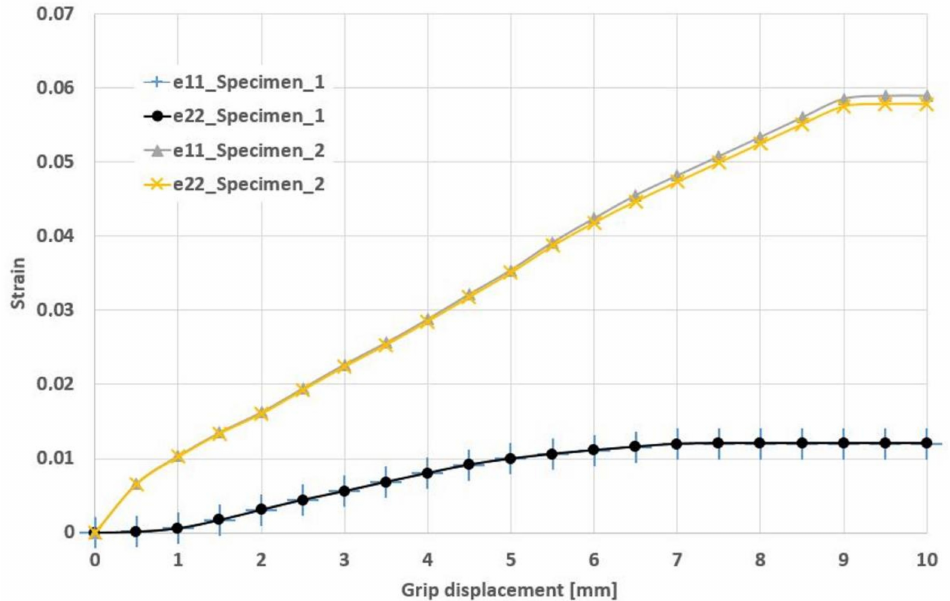
Figure 17. The evolution of plastic strain components (e11 and e22) for Specimen_1 and Specimen_2 versus grip displacement in the centre of the sample.